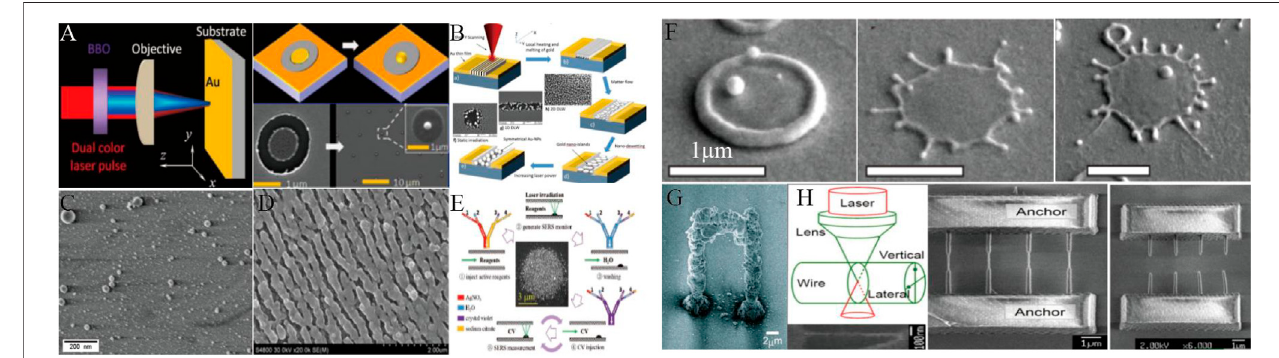
FIGURE2| Femtosecondlaserbottom-uppreparationmethod (A) femtosecondlaserdirect-writeprocessingexperimentalsetupandsinglenanoparticlesformed byirradiationonan earlysemiconductor substrate[48] (B) mechanisms ofnanoparticlepreparationongold fi lmsbyfemtosecondlaserdirectwritingprocessing[49] (C) SEM image of the deposited material after laser pulse irradiation [34] (D) laser deposition of gold nanoparticles [35] (E) nanostructures formed by femtosecond laser- induced metal reduction [32] (F) aggregate photo-induced growth of silver nanoparticles prepared by sputtering deposition [36] (G) three-dimensional structures formed by two-photon polymerization preparation [30] (H) hanging wire array diagram